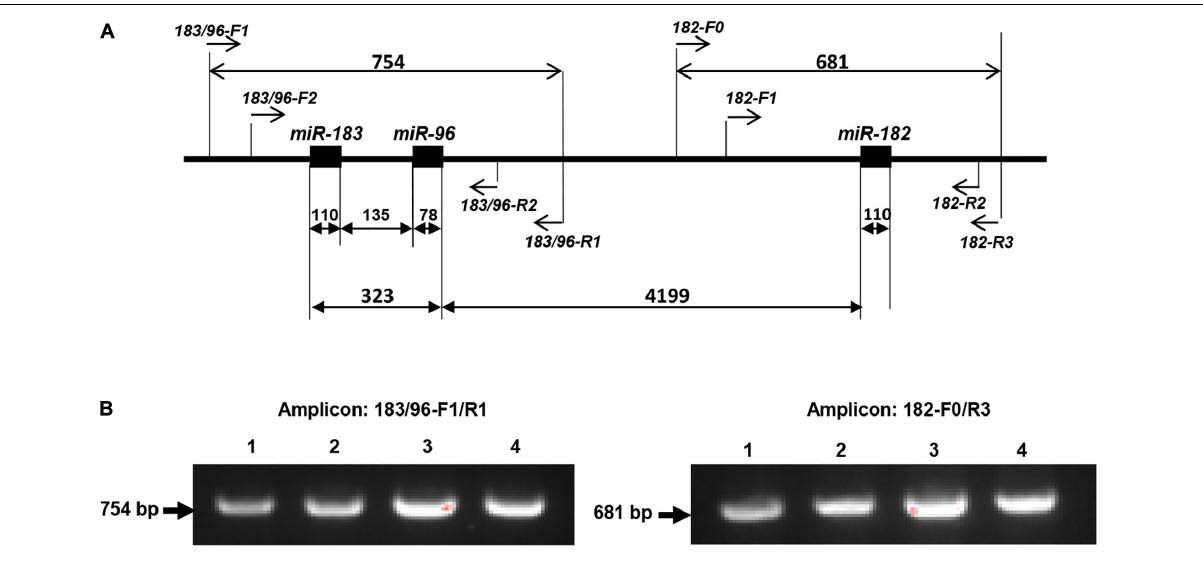
FIGURE 1 | PCR-sequencing strategy for mutation screening in the miR-183/96/182 cluster. (A) Schematic illustration of the miR-183/96/182 cluster in relation to the PCR and sequencing primers. Pre-miR-183/96 is amplified by 183/96-F1/R1 and sequenced by primers of 183/96-F2 and 183/96-R2. pre-miR-182 was amplified with primers 182-F0/R3, and sequenced by 182-F1 and 182-R2. The numbers above the double arrows indicate the sizes of the marked fragments in base pairs (bp). (B) Examples of amplification